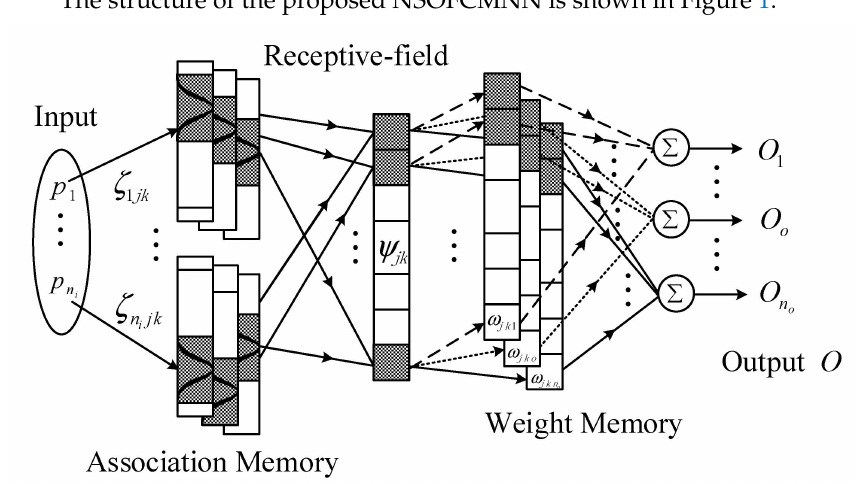
Figure 1. Structure of a novel self-organizing fuzzy cerebellar model neural network. (NSOFCMNN). NSOFCMNN has a five-layer